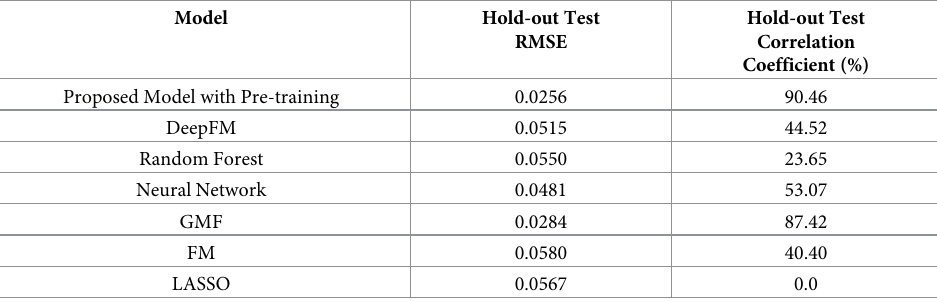
Table 2. Yield prediction performance of the competing models using hold-out